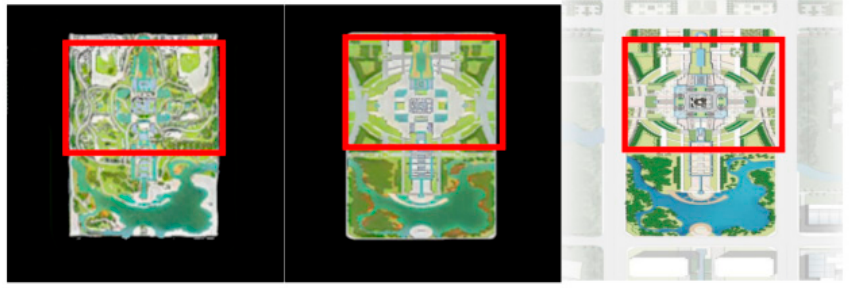
Figure 20. Test sample 6. Comparison of experimental results.